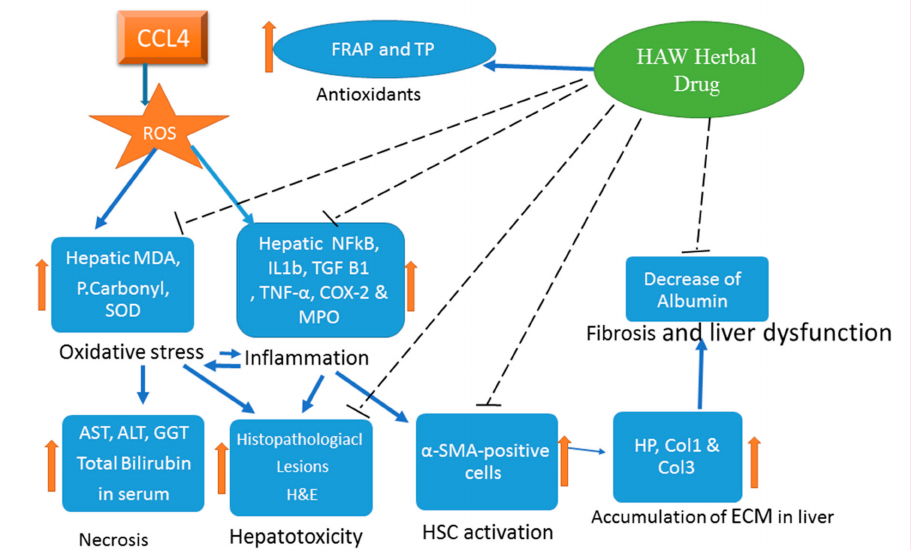
Figure 7. A graphical abstract highlighting the protective e ff ect of HAW in CCl4-induced liver fibrosis by blocking the pro-oxidant machinery and the downregulation of the inflammatory and profibrotic responses. The protective e ff ects include reducing deposition. Liver toxicity, improving the liver histology and decreasing